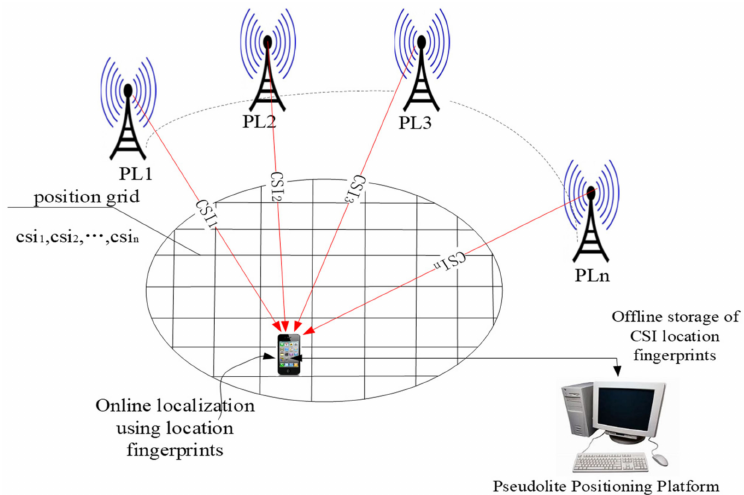
Figure 2. The principle of pseudolite fingerprint